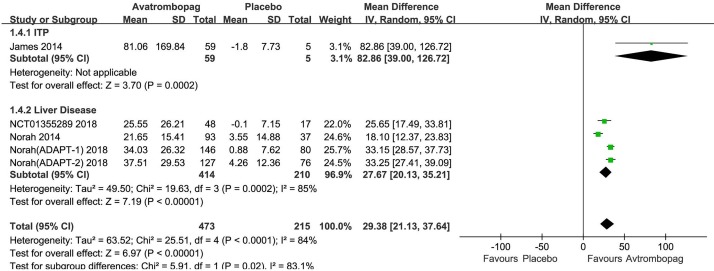
Forest plot: Effects of avatrombopag and placebo on platelet count in the presence of different comorbidities.